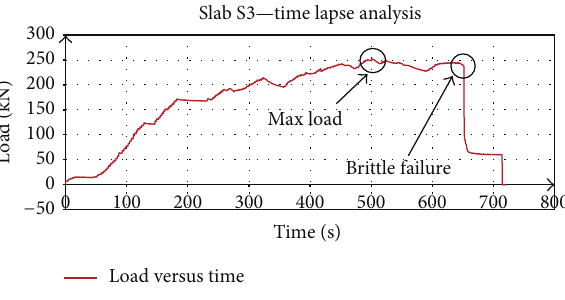
Figure 42: Load V’s time slab S3.